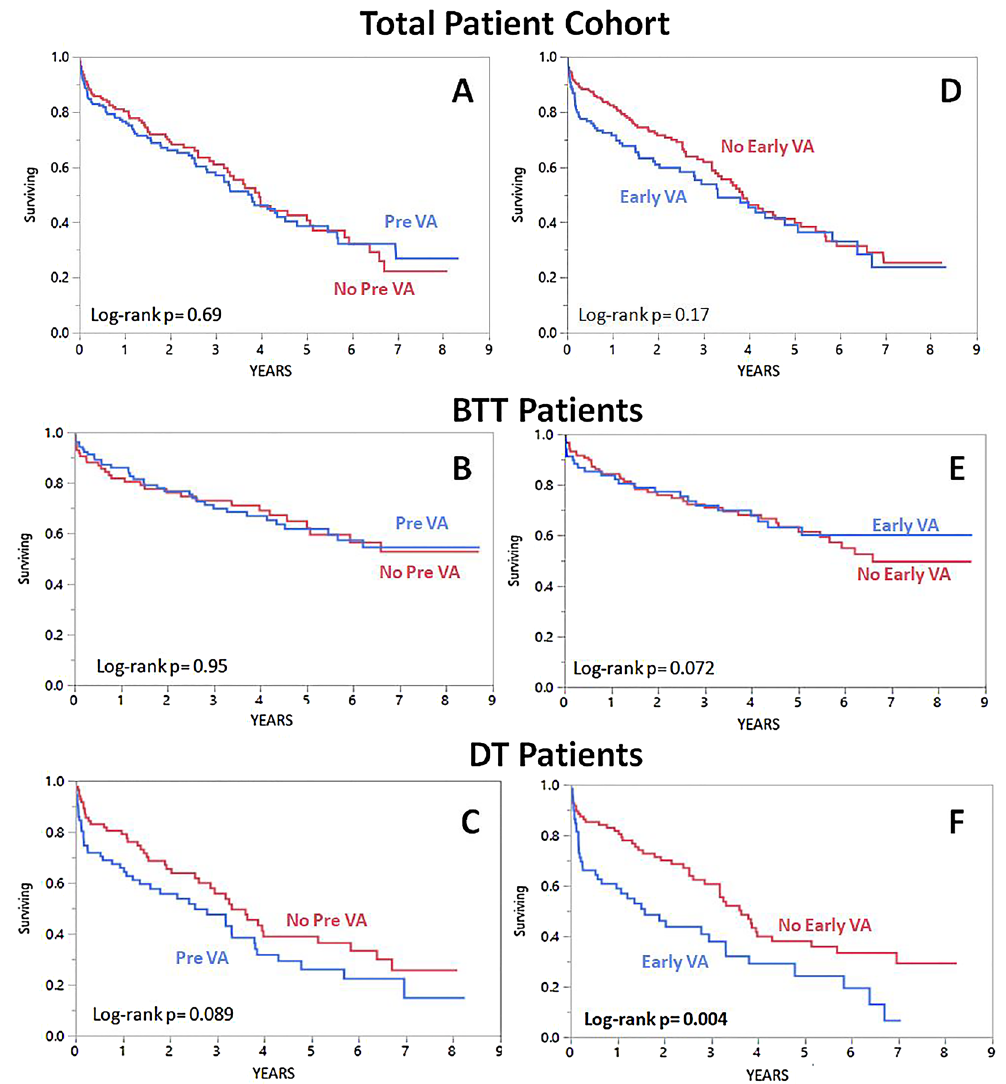
Figure 1. Kaplan–Meyer curves for mortality dichotomized by the existence of pre-LVAD VA ( A–C ) and early post-LVAD VA ( D–F ) in all the patient cohort, the BTT group and the DT group.